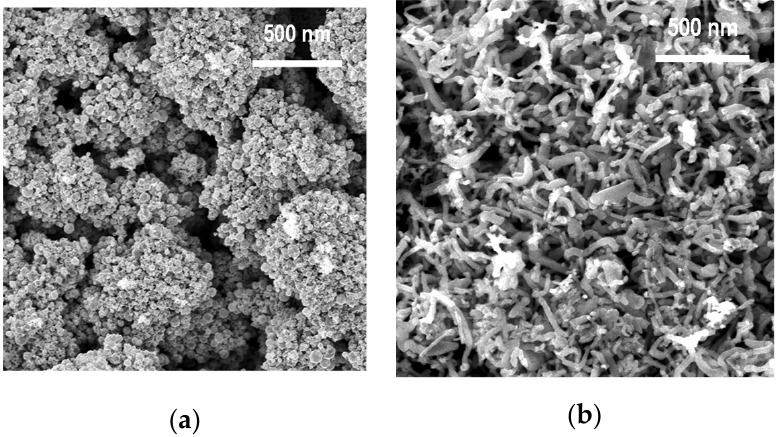
Figure 2. The SEM images of the spherical (a) and rod-shaped (b) ZnO-NPs obtained by the PECVD method.